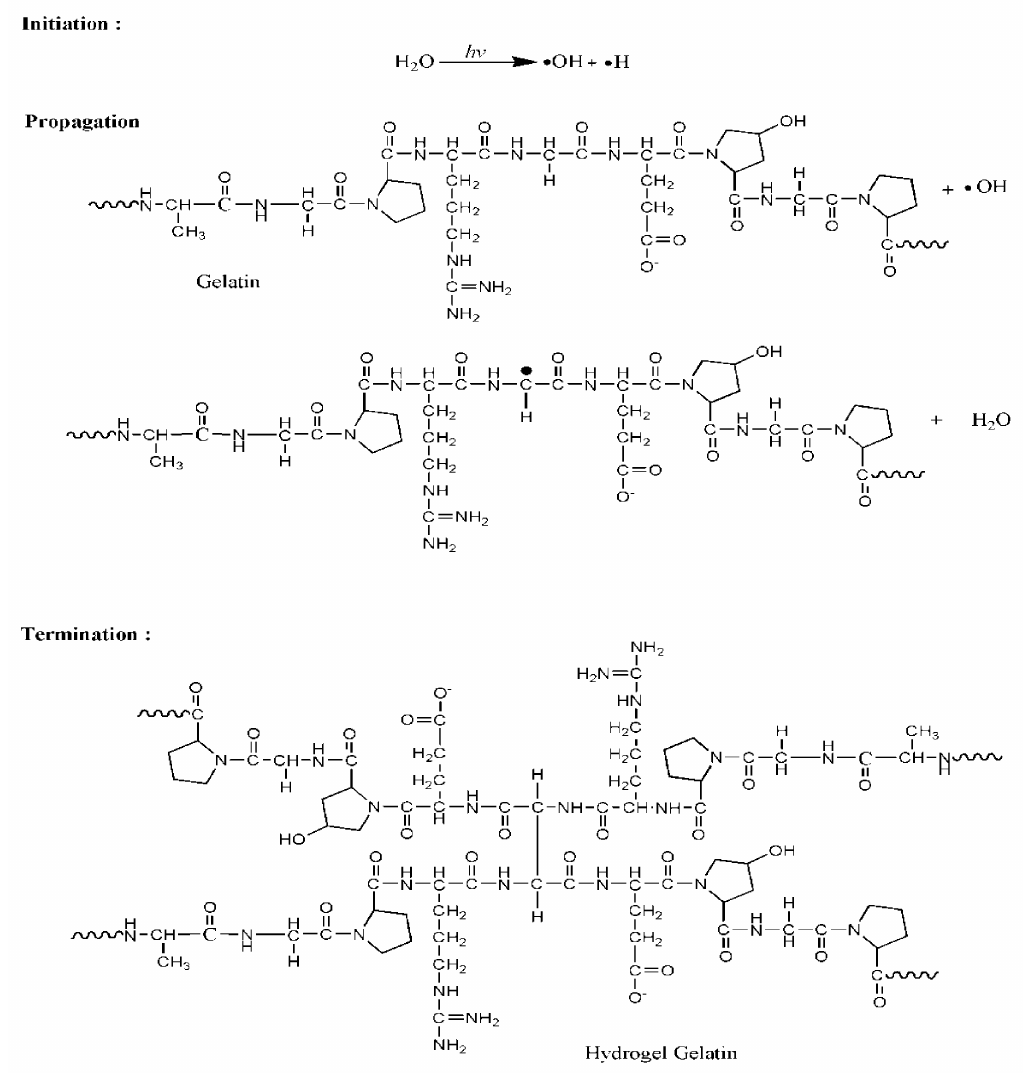
Figure 4. Proposed gelatin-crosslinking mechanism for the formation of hydrogel gelatin by gamma